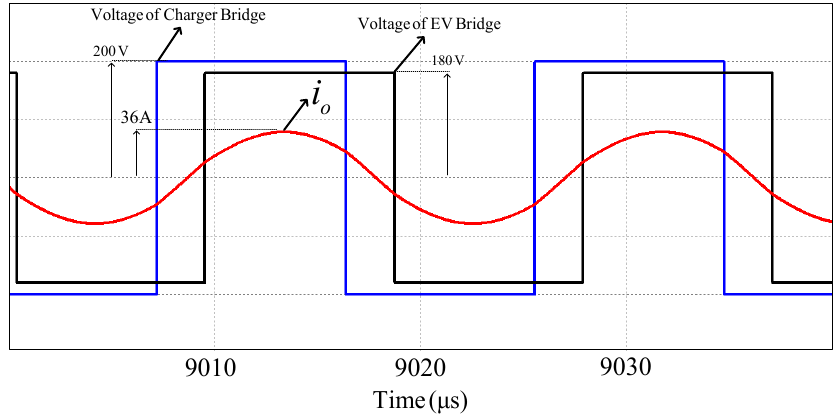
Figure 8. Output voltage of charger bridge, EV bridge and I o under unequal voltages condition with τ 1 ≈ 4.7µs and τ 2 = 1µs.